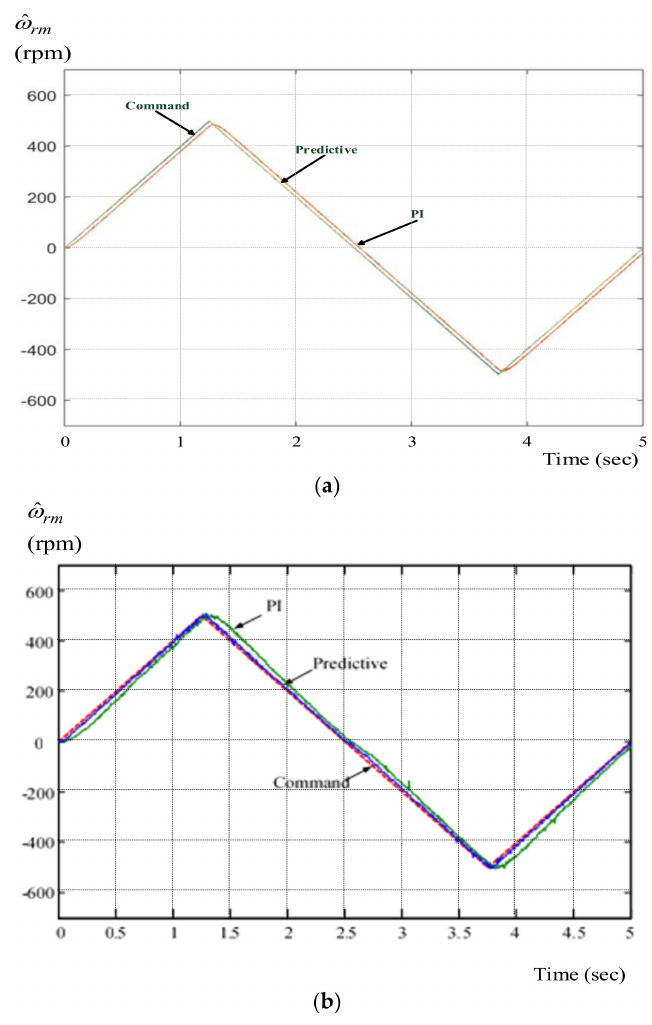
Figure 14. Triangular tracking responses using di ff erent controllers. ( a ) Simulated; ( b )